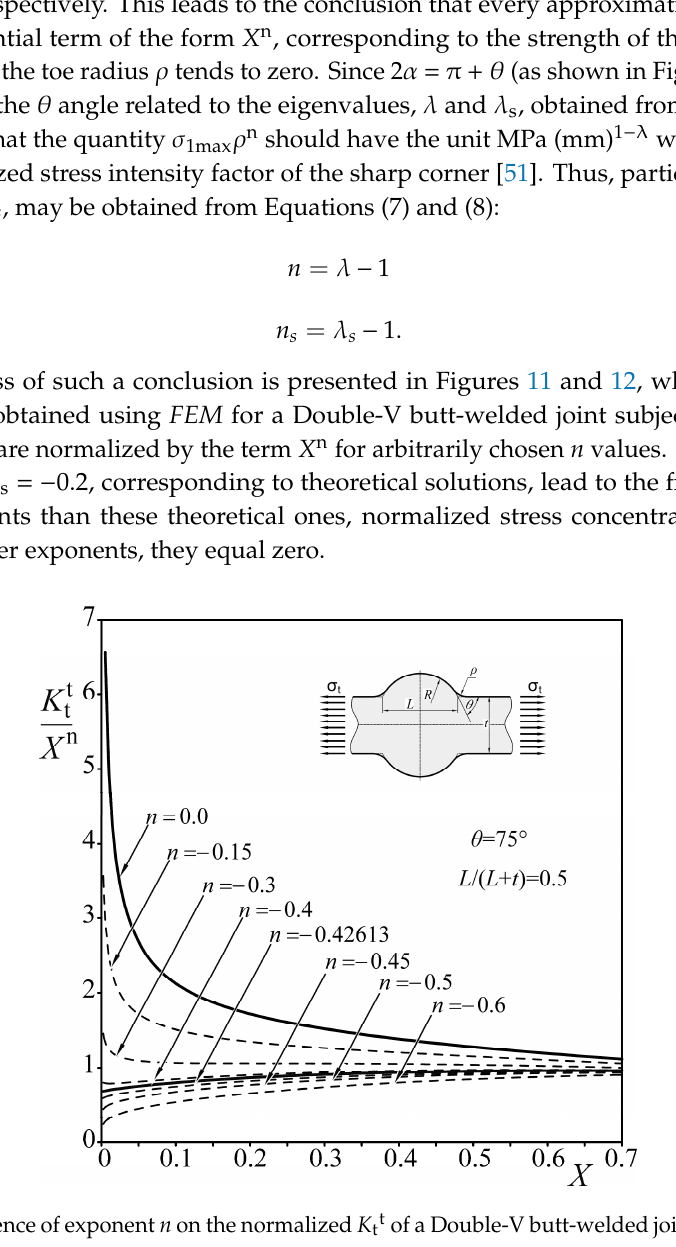
Figure 12. Influence of exponent n on the normalized K ts of a Double-V butt-welded joint subjected to shear, when Y = 0.5 and θ = 45°. Unfortunately, an analytical solution of the characteristic Equation (5) is not known and approximating numerical procedures need to be applied for calculating λ . Thus, Equation (9), based on numerical solutions of Equations (5) and (7), is proposed: Equation (9) is valid in the range 0 ≤ θ ≤ π /2, representing values of exponent n with an accuracy of 5 significant digits.